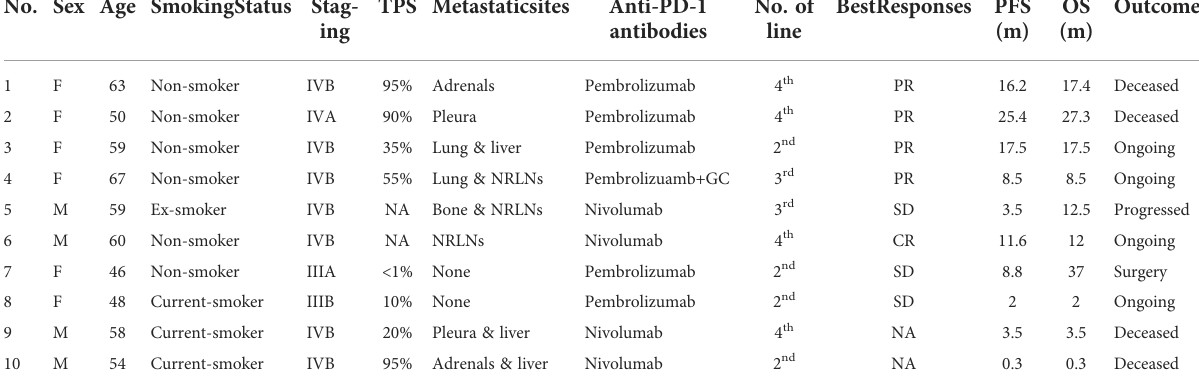
TABLE 1 Clinicopathological factors of the CHCSJ